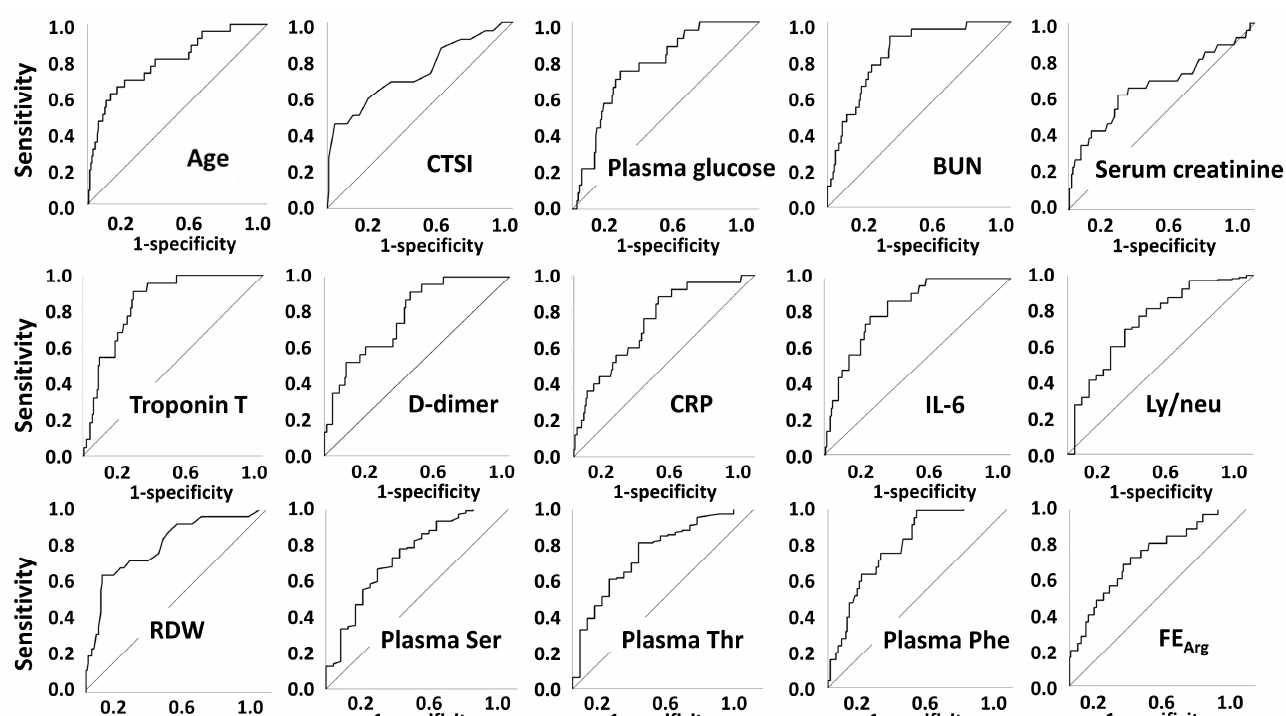
Figure 1. ROC curves of parameters with area under the ROC curve above 0.700 for in-hospital mortality. Abbreviations: CTSI, CT severity index; BUN, blood urea nitrogen; eGFR, estimated glomerular filtration rate; hsCRP, high-sensitivity C-reactive protein; IL-6, interleukin 6; RDW, red blood cell distribution width; Ly/neu, lymphocyte/neutrophil; FE, fractional excretion. The strongest parameters were enrolled to logistic regression models, separately with serum creatinine or BUN.